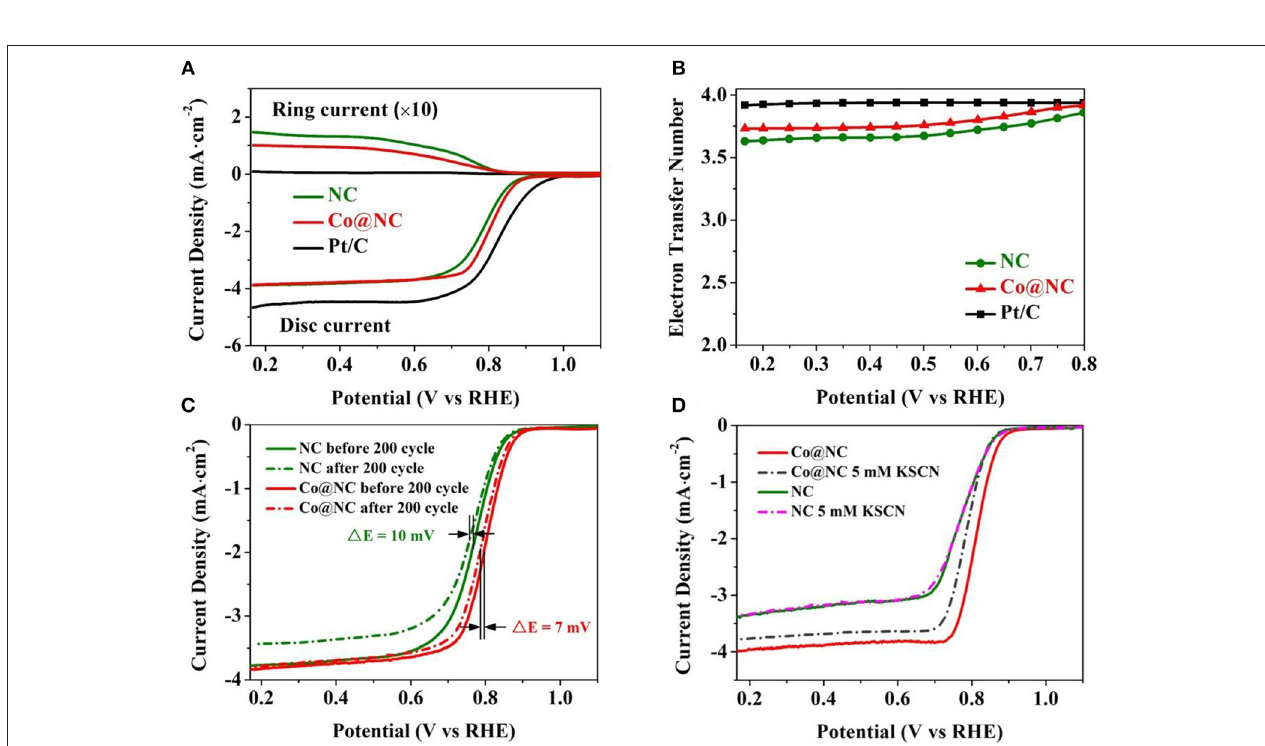
FIGURE 4 | (A) RRDE disk and ring currents recorded. (B) Electron transfer number of the Co@NC, NC and Pt/C (electrolyte: O 2 -saturated 0.1M KOH, scan rate: 10 mV · s − 1 , rotational speed: 1,600 rpm). ORR polarization plots of (C) Co@NC and NC before and after continuously 200 cycles (electrolyte: O 2 -saturated 0.1M KOH). (D) Effect of KSCN interaction on the catalytic activity of Co@NC and